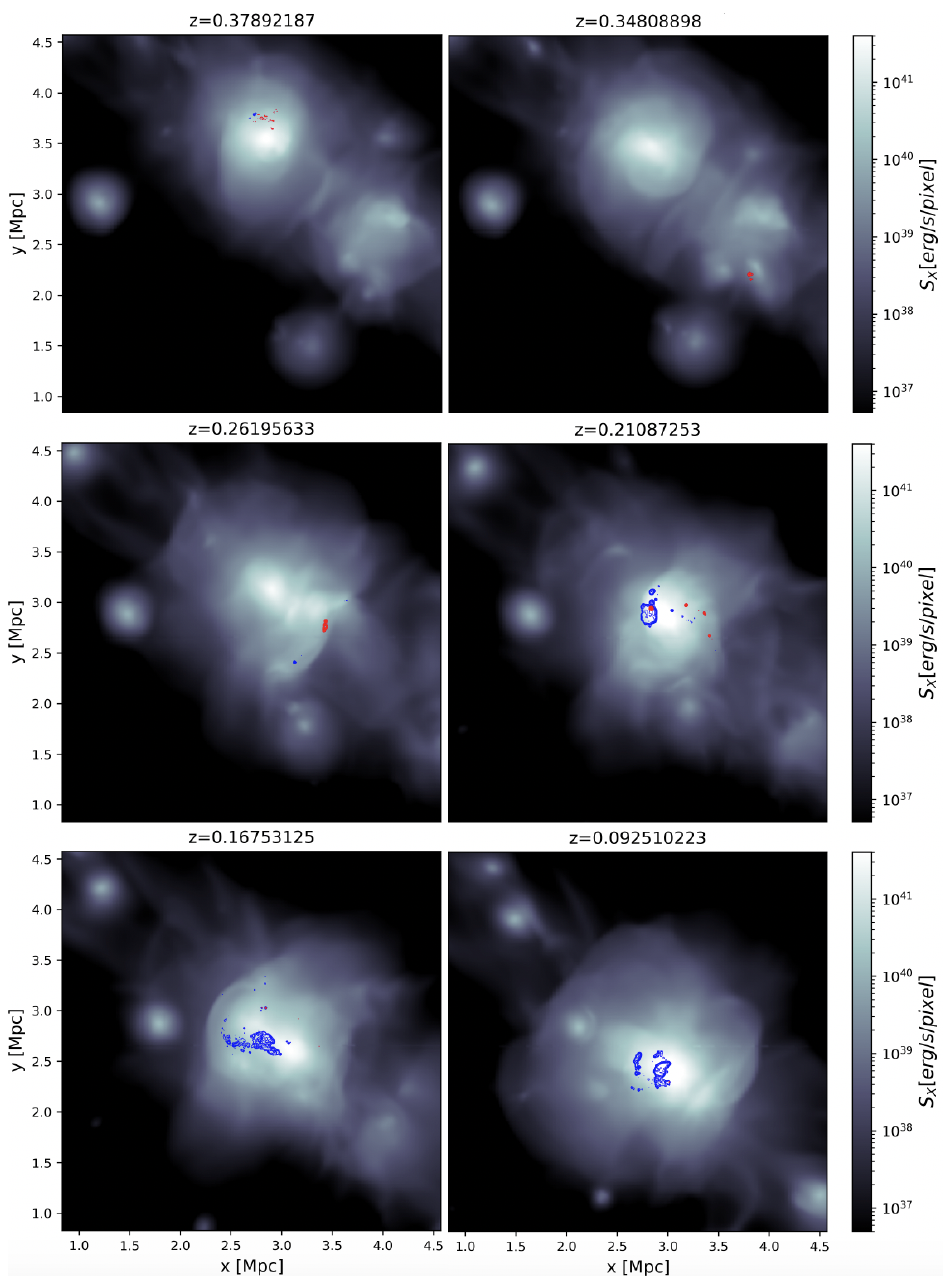
Figure 8. Evolution of the X-ray surface brightness (grey colours) and of the detectable radio emission at 50 MHz with LOFAR LBA for z ≤ 0.4, for all electrons seeded by radio jets at z = 0.5 and later re-accelerated by shocks and turbulence (CST model, red contours), or also considering the additional contribution from electrons seeded by merger shock waves from z = 0.4 (CST model, blue contours). The full movie of this sequence can be watched at https://youtu.be/MPEFiIzr-V8 (accessed on 17 February